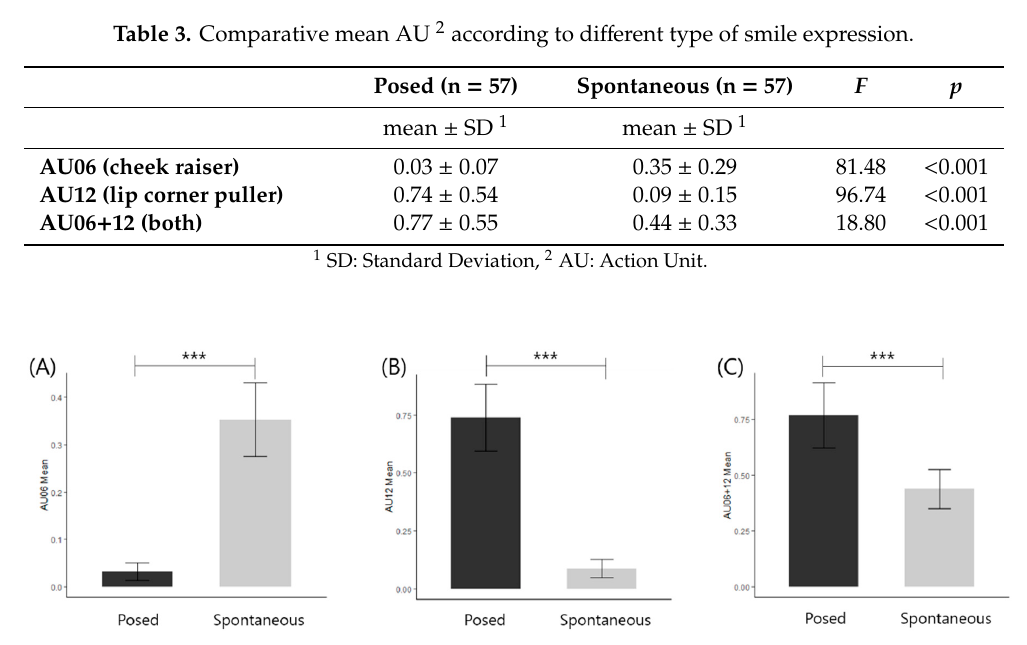
Table 4. Comparison of smile expression by left- and right face based on facial landmarks.